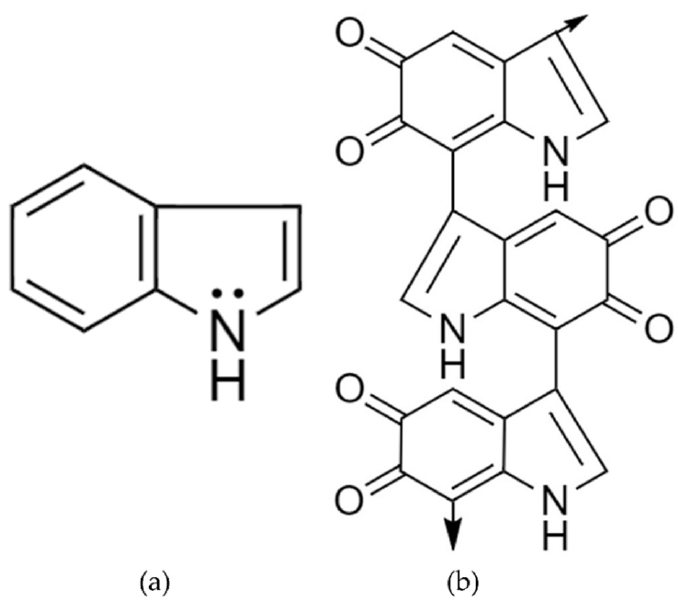
Figure 15. Melanin-related structures and some properties. ( a ) Basic structure (indolic ring). ( b ) Resonance structures that are probably involved in the process of color. The arrows show the points and sense of polymerization [119].